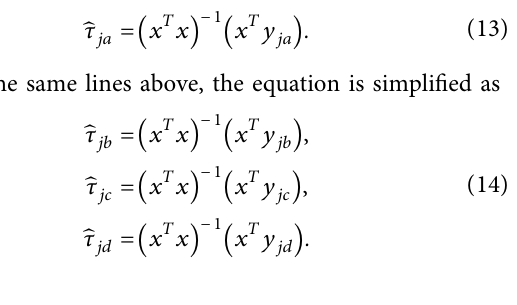
Table 1: Normality test.